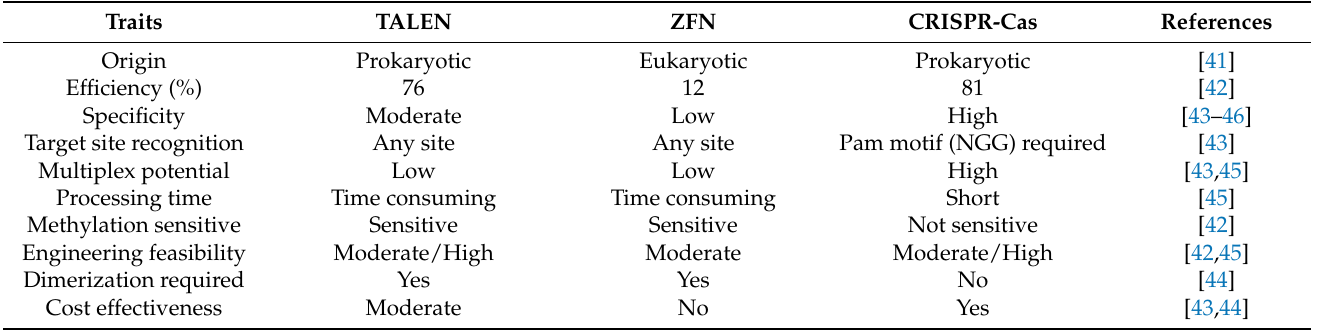
Table 1. Comparison between TALEN, ZFN, and CRISPR-Cas gene editing